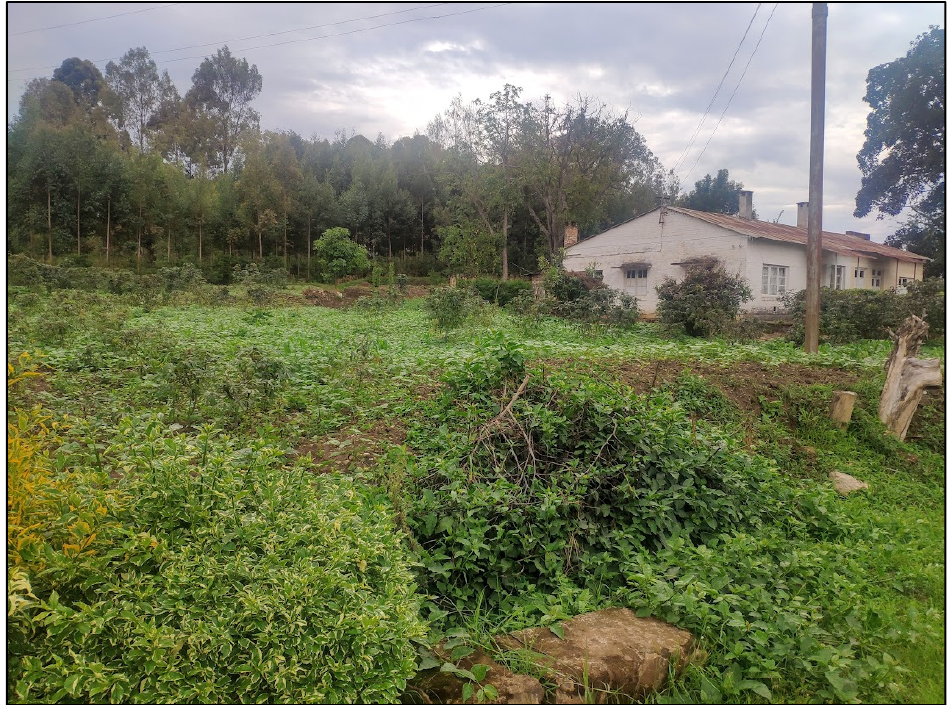
Figure 2. Unused land converted to agricultural land due to the COVID-19 pandemic. Photo taken by Jan Machá č ek, one of the authors.